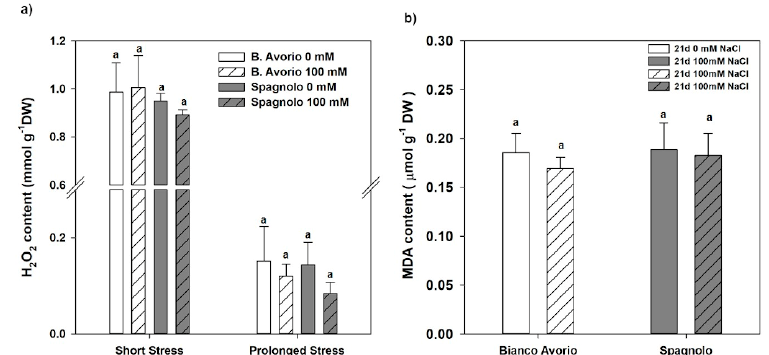
Figure 5. ( a ) H 2 O 2 content measured in leaves of “Bianco Avorio” and “Spagnolo” genotypes of C. cardunculus var altilis after 2 and 21 days of 0 (control) and 100 mM (salinity treatment) NaCl; ( b ) MDA content in leaves “Bianco Avorio” and “Spagnolo” genotypes of C. cardunculus var altilis measured upon prolonged salt stress. Each value represents the mean ± SD of three biological replicates. Values indicated with different letters are significantly different between genotypes and treatments within the same sampling time at p < 0.05, by analysis of variance (ANOVA).